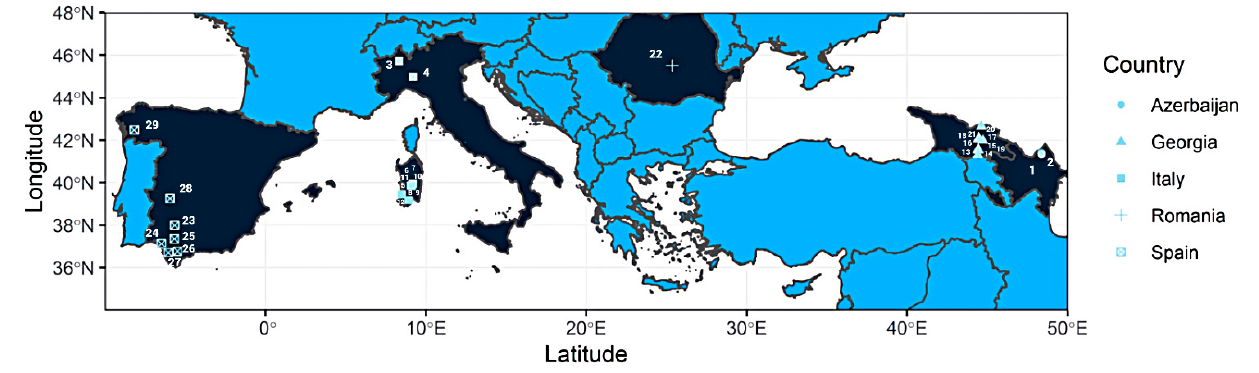
Figure 1. Locations of the sampled wild grape berries from V. vinifera ssp. sylvestris (Gmelin)